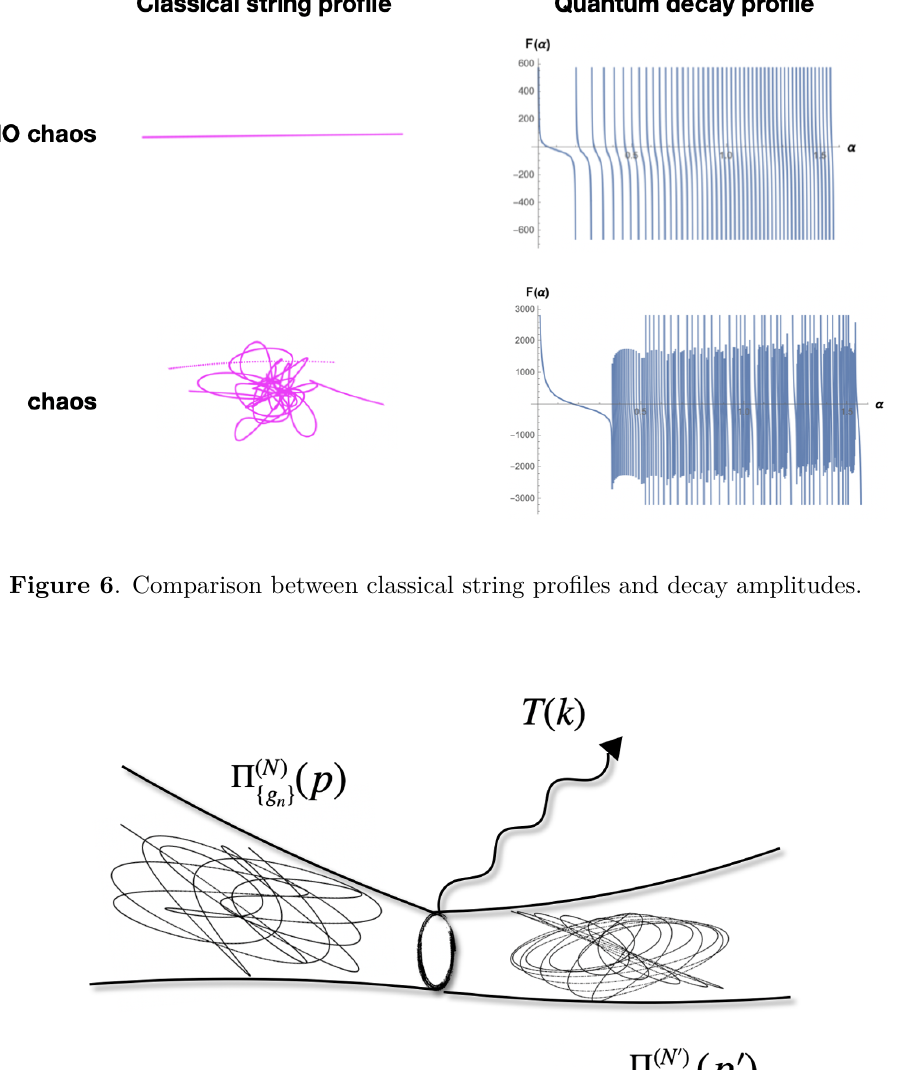
Figure 7 . Picture of the decay amplitude where a representative microstate Π ( N ) Π ( N 0 ) emitting a tachyon T { g 0 } n 0